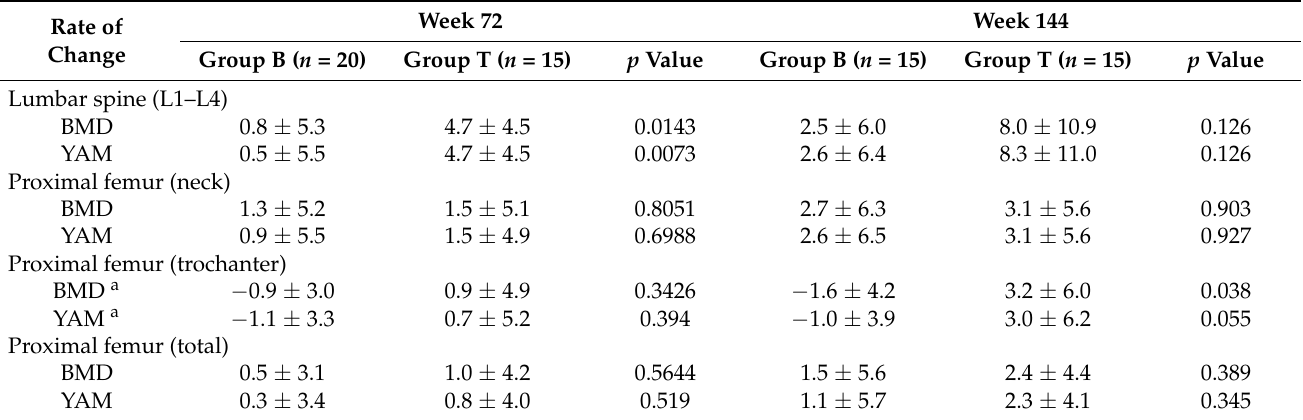
Table 2. Comparison of secondary endpoints in Group B and Group T at 72 and 144 weeks from baseline (intention-to-treat